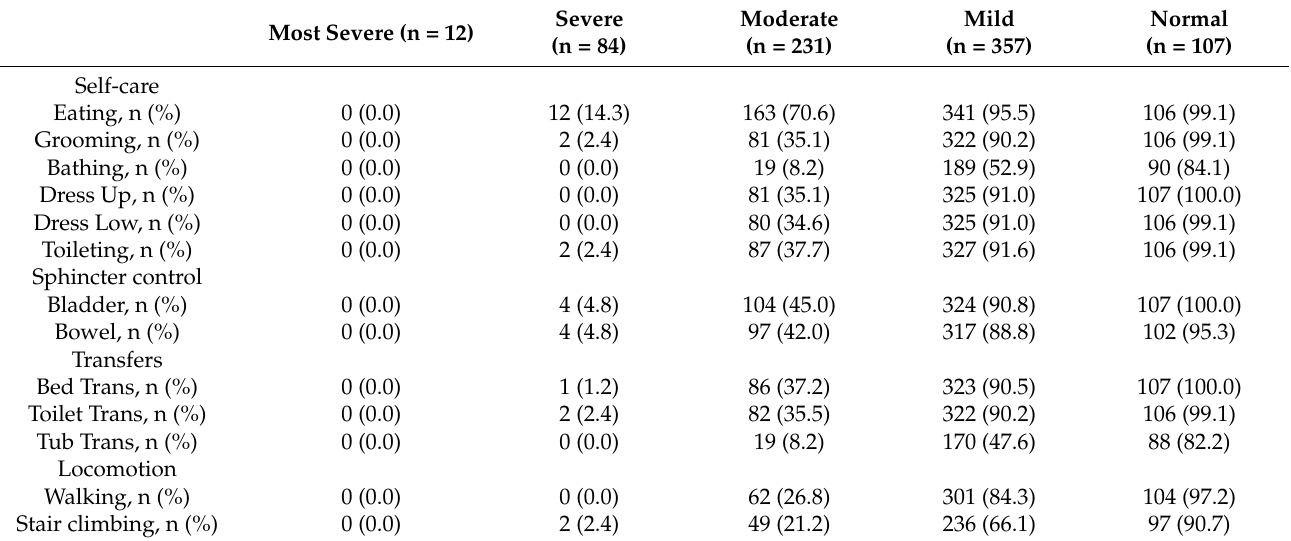
Table 3. Percentage of independent ADLs by CBA severity (Functional Independence Measure motor item).